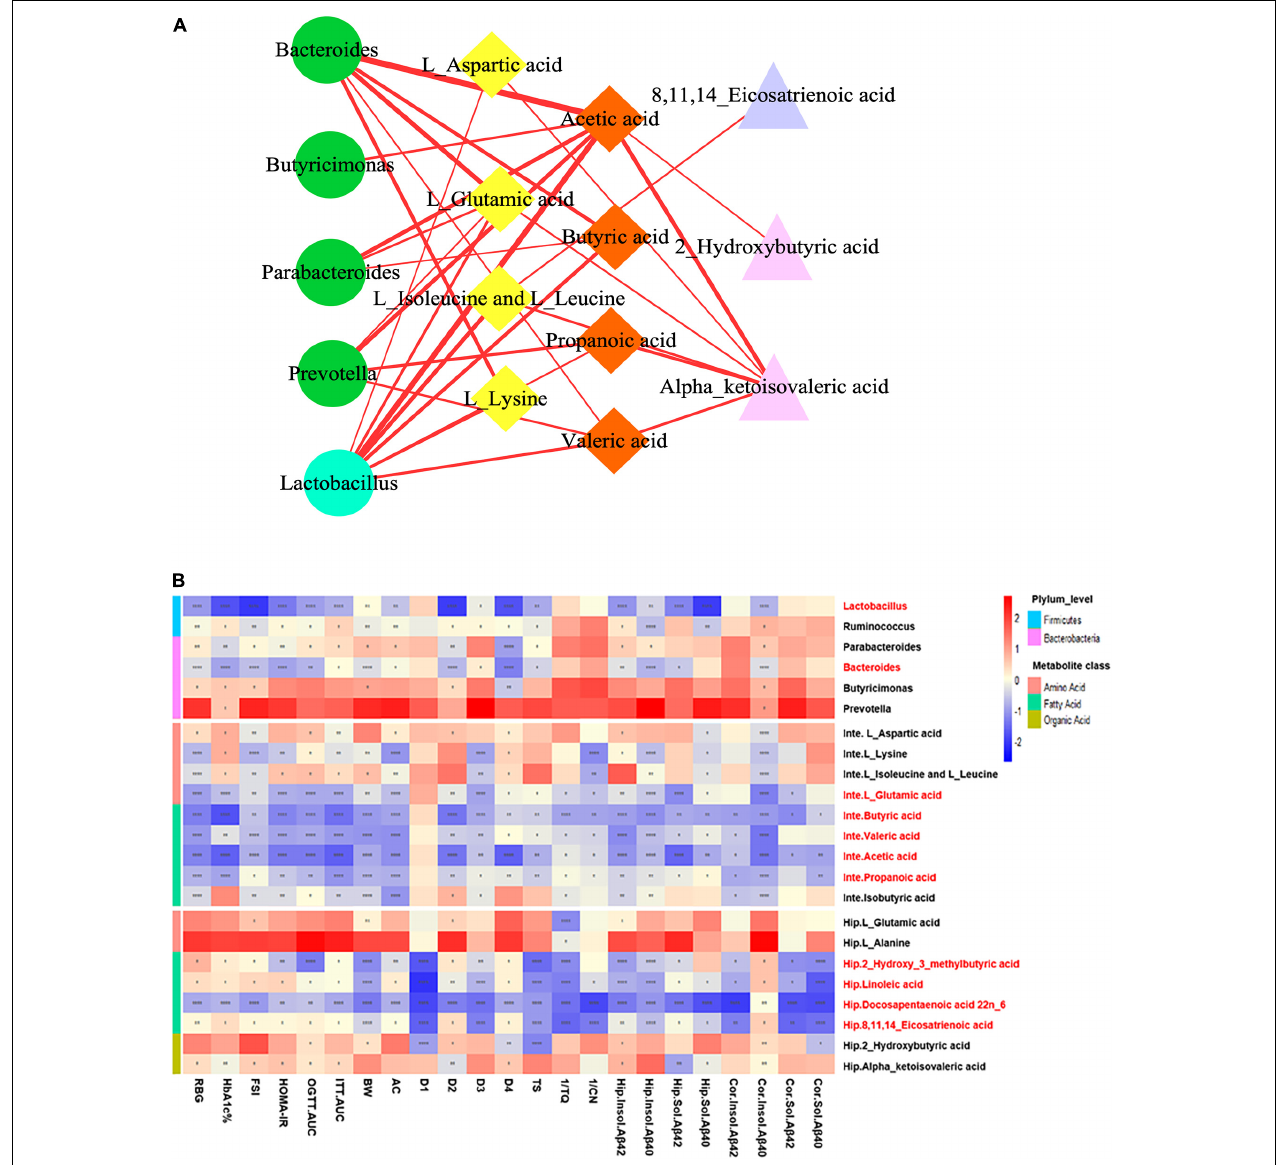
FIGURE 8 | Correlation analysis integrating bacterial genera, intestinal metabolites, hippocampus metabolites, and DACD phenotypes. (A) Network diagram showing the correlation among bacterial genera (green circle denotes Bacteroidetes ; cyan circle indicates Firmicutes ), intestinal metabolites (yellow rhombus denotes aliphatic amino acids; orange rhombus indicates short chain fatty acids), and hippocampus metabolites (purple triangle denotes unsaturated fatty acids; pink triangle indicates aliphatic organic acids). (B) Heatmap showing the correlation between potential biomarkers and DACD phenotype. The degree of correlation is shown by the gradient change of red (positive correlation) and blue (negative correlation). * p < 0.05, ** p < 0.01, *** p < 0.001, **** p < 0.0001. RBG, random blood glucose; HbA1c%, glycosylated hemoglobin; FSI, fasting serum insulin; HOMA-IR, homeostasis model of assessment for insulin resistance; OGTT-AUC, area under the curve of the oral glucose tolerance test; ITT-AUC, area under the curve of the insulin secretion test; BW, body weight; AC, abdominal circumference; D1–D4, escape latency during a 4-day training course in the orientation navigation test of Morris water maze test; TS, time in searching original platform location in the spatial exploration test of Morris water maze test; 1/TQ, the reciprocal of time spent in each quadrant (%) in the spatial exploration test of Morris water maze test; 1/CN, the reciprocal of crossing number of the original platform location in the spatial exploration test of Morris water maze test; Inte, intestine; Hip, hippocampus; Cor,